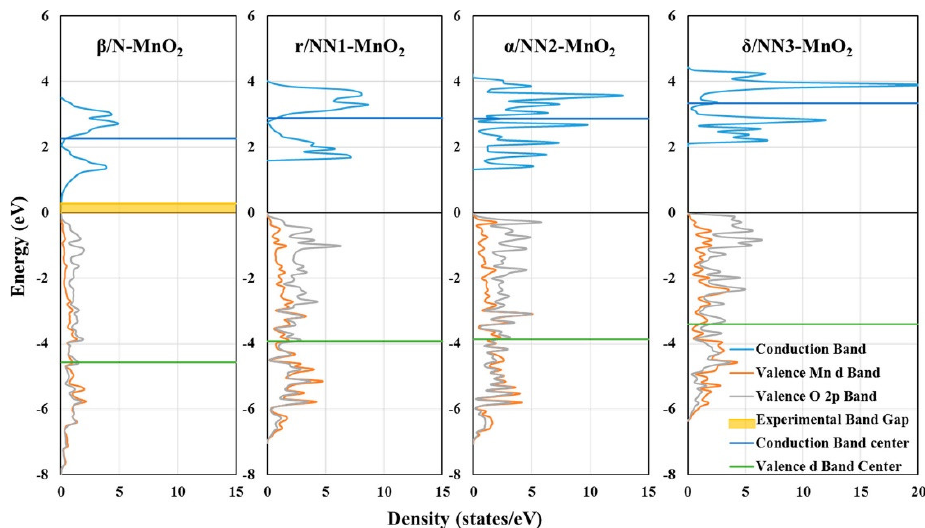
Figure 15. Density of states plot for different polymorphs of MnO 2 . Valence Mn-d band center shifts upward and closer to the Fermi level as we move toward more non-native polymorphs. (Reprinted from ref. [130] with permission from the Journal of Physical Chemistry C. Copyright © 2019, American Chemical Society).